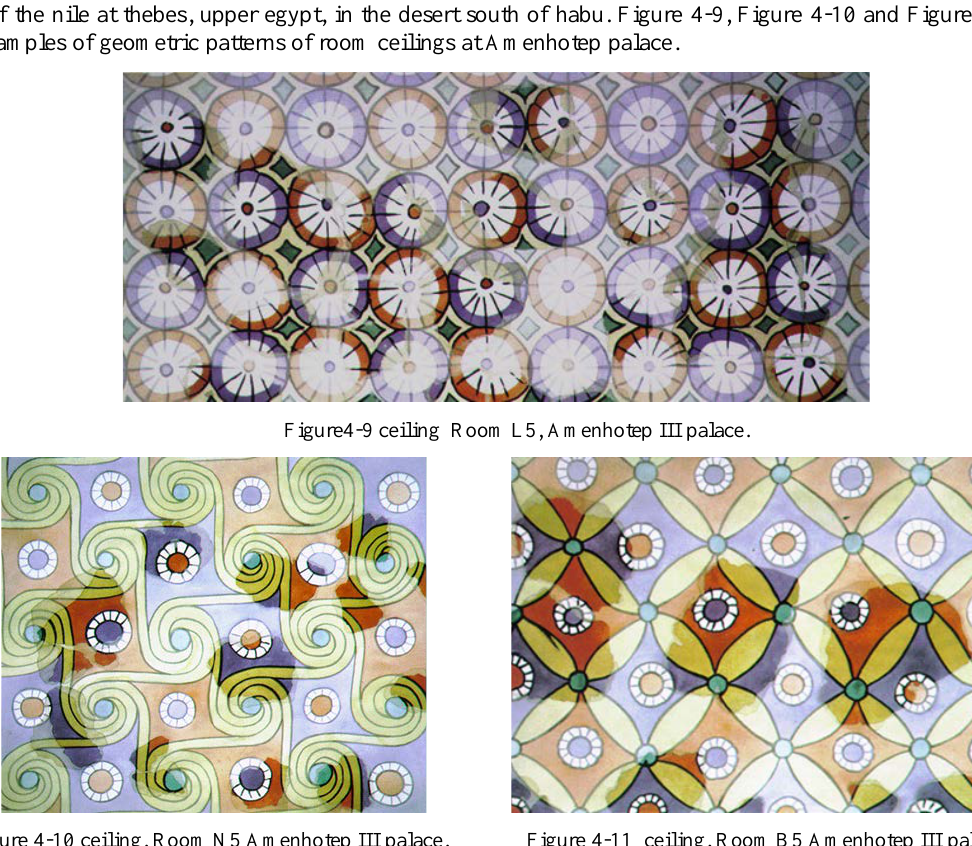
Figure 4-10 ceiling, Room N5 Amenhotep III palace. Figure 4-11 ceiling, Room B5 Amenhotep III